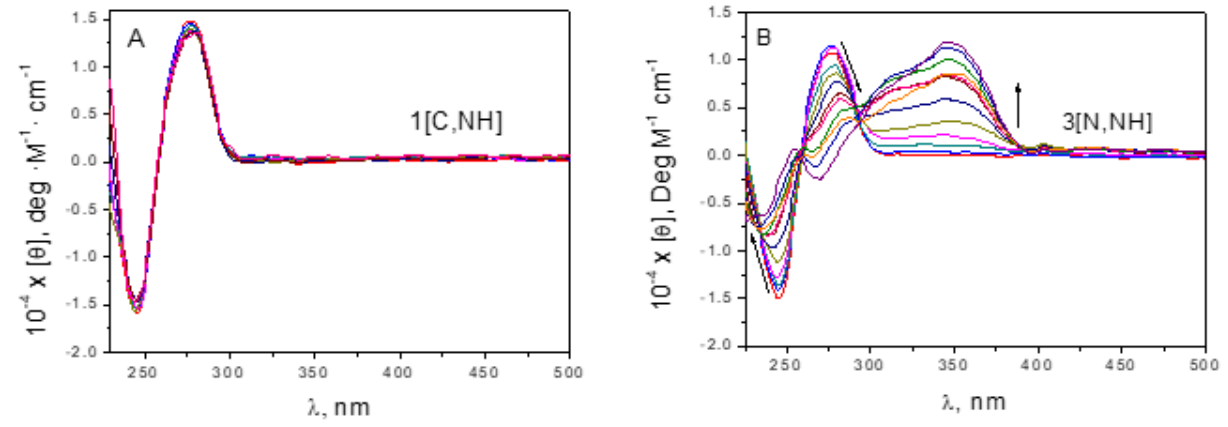
Figure 5. Circular dichroism spectra of DNA with ( A ) 1[C,NH] and ( B ) 3[N,NH]